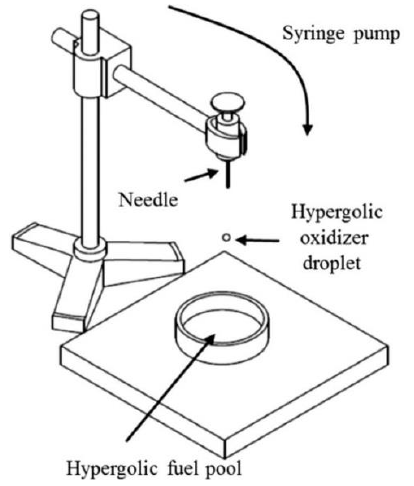
Fig. 1. Schematic drawing of the drop test stand